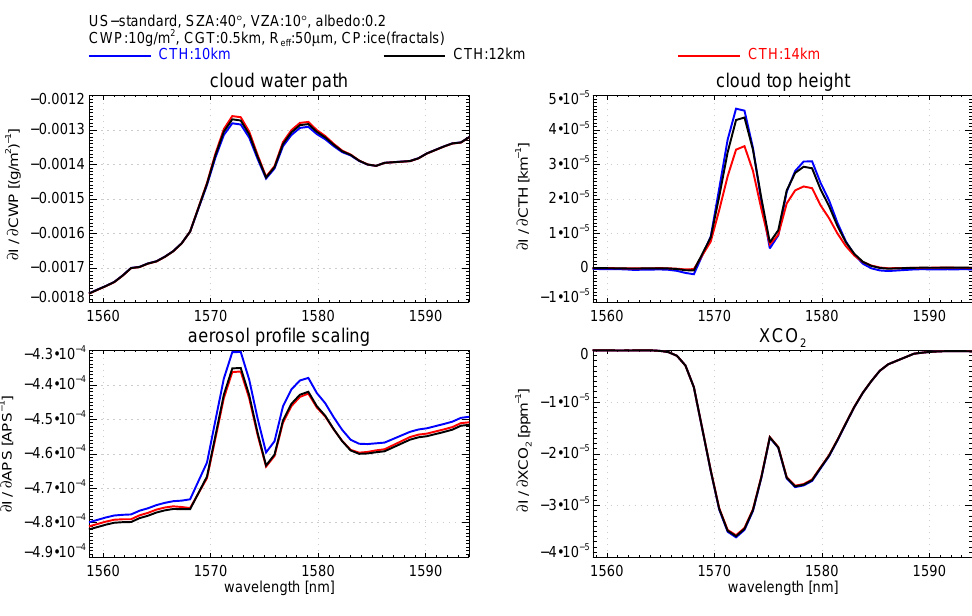
Fig. 1. Weighting functions in the CO 2 fit window for three cloud scenarios based on a US-standard atmosphere including an optically thin ice cloud with a cloud top height of 10km (blue), 12km (black), and 14km (red): cloud water/ice path (top/left), cloud top height (top/right), scaling of the aerosol profile (bottom/left), and XCO 2 (bottom/right). The weighting functions are calculated with the SCIATRAN 3.0 radiative transfer code and are folded with SCIAMACHY’s slit